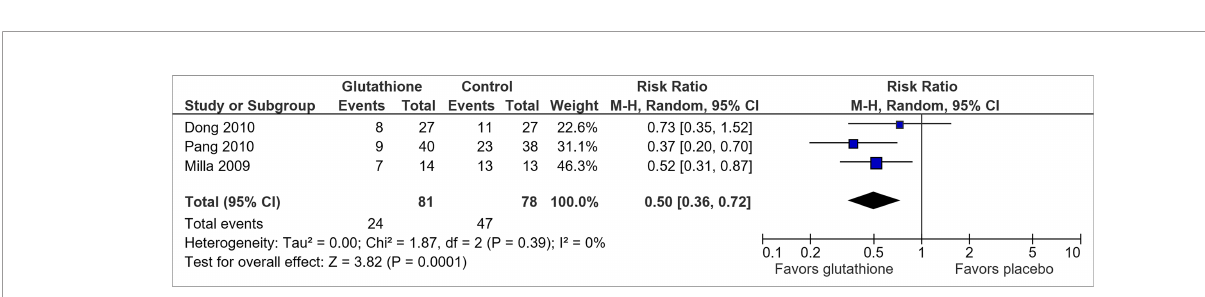
FIGURE 4 | Forest plot for comparison of the incidence of OIPN of CTCAE grade ≥ 2: N-acetylcysteine versus placebo.